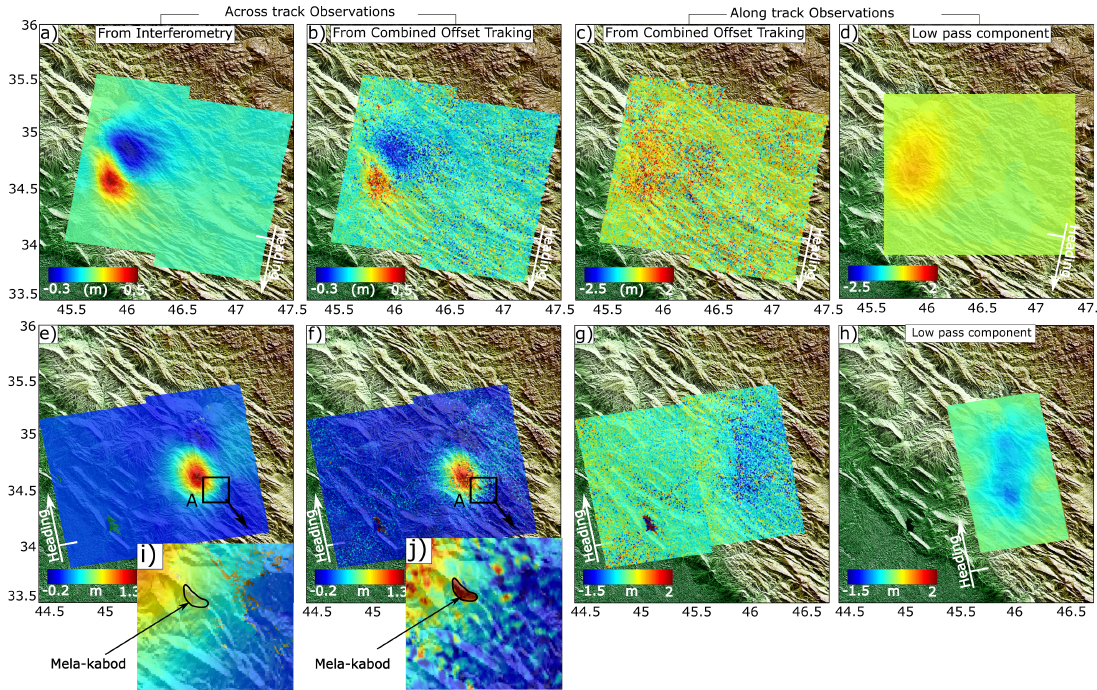
Figure 3. Interferometric versus combined offset tracking. ( a , e ) Across-track displacement map (unwrapped) derived from the interferometry in both descending and ascending geometries, respectively. ( b , f ) Across-track displacement map retrieved from the combined offset tracking in both descending and ascending geometries, respectively. ( c , g ) Along-track displacement map resulting from the combined offset tracking in descending and ascending geometries, respectively. ( d , h ) Low-pass components of ( c , g ), respectively. ( i , j ) Close-up views of ( e , f ), respectively, for a region affected by a big landslide (see Section 4.3.1). In ( c , d , g , h ), positive (red) and negative (blue) signs in